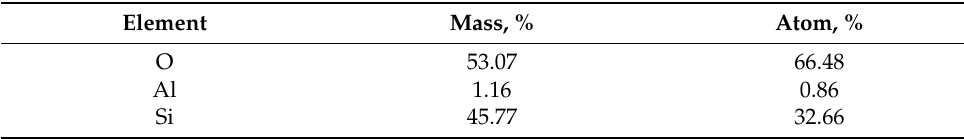
Table 1. EDX results—diatomite.